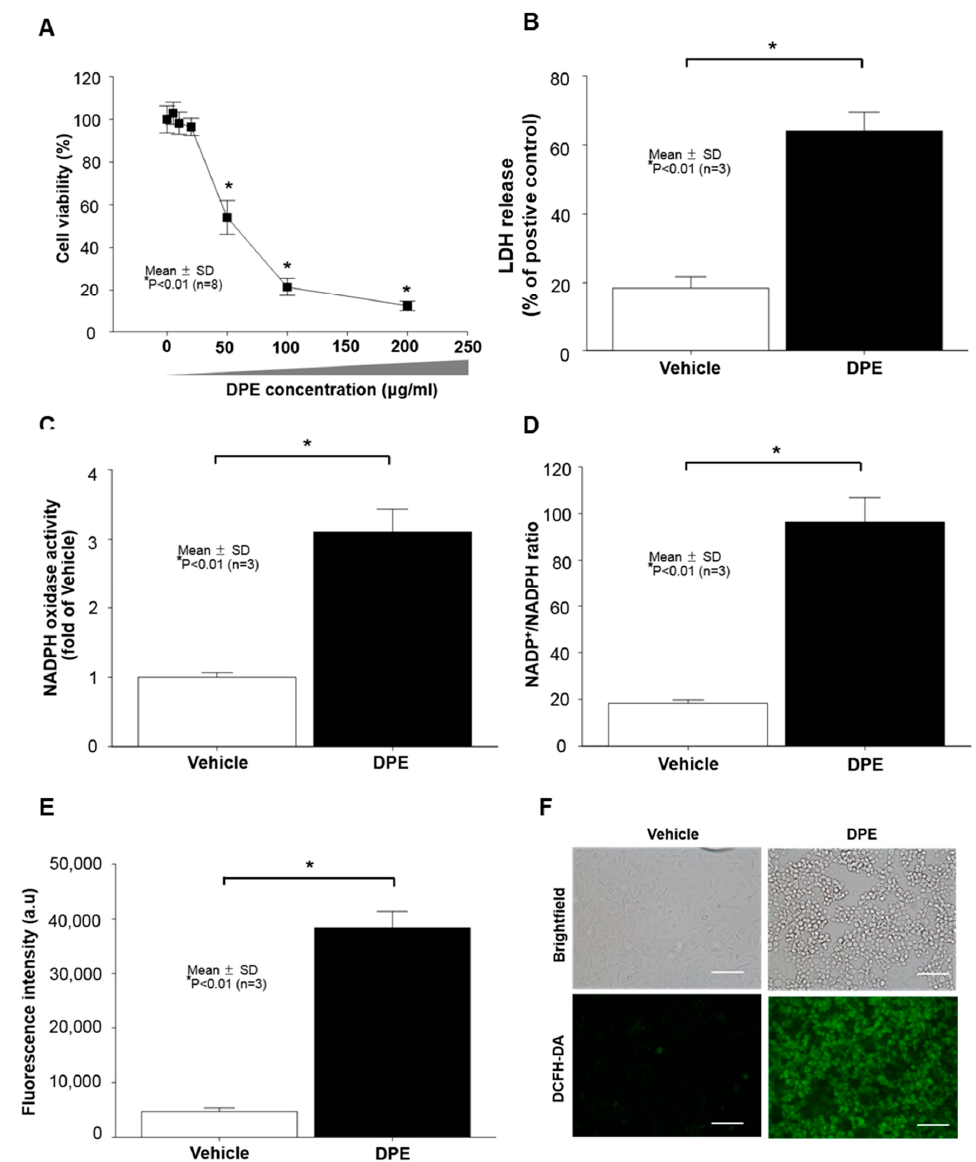
Figure 1. Diesel particulate extract (DPE) induces keratinocyte (KC) apoptosis, paralleled by increased NADPH oxidase activity and reactive oxygen species (ROS) production. Human HaCaT KC were treated with DPE (100 μ g/mL or as indicated) for 24 hrs. Cell viability was measured by a CCK-8 assay kit ( A ). Cell cytotoxicity was further determined by an LDH assay and results were expressed as LDH release compared to the positive control consisting of 0.1% SDS (yielding 100% LDH release) ( B ). In order to measure the levels of NADPH oxidation, cell membrane fractions were obtained as described in Materials and Methods. Activity of NAPDH oxidases was determined by either lucigenin chemiluminescence assay using N , N ′ -Dimethyl-9,9 ′ -biacridinium dinitrate ( C ) or measuring the ratio of NADP+ to NADPH with LC-ESI-MS/MS (API 3200 QTRAP mass, AB/SCIEX) by multiple reaction monitoring mode (MRM) ( D ). Intercellular ROS production was determined by either a fluorospectrophotometer ( E ) or fluorescence microscopy ( F ) with the oxidant-sensing probe 2 ′ ,7 ′ -dichlorodihydrofluorescein diacetate (DCFH-DA). All values are mean ± SD ( n = 3). Statistical significance was calculated using the unpaired Student’s t -test, and significance was defined as p < 0.01 vs. vehicle control (or untreated control). Bar = 500 μ m.